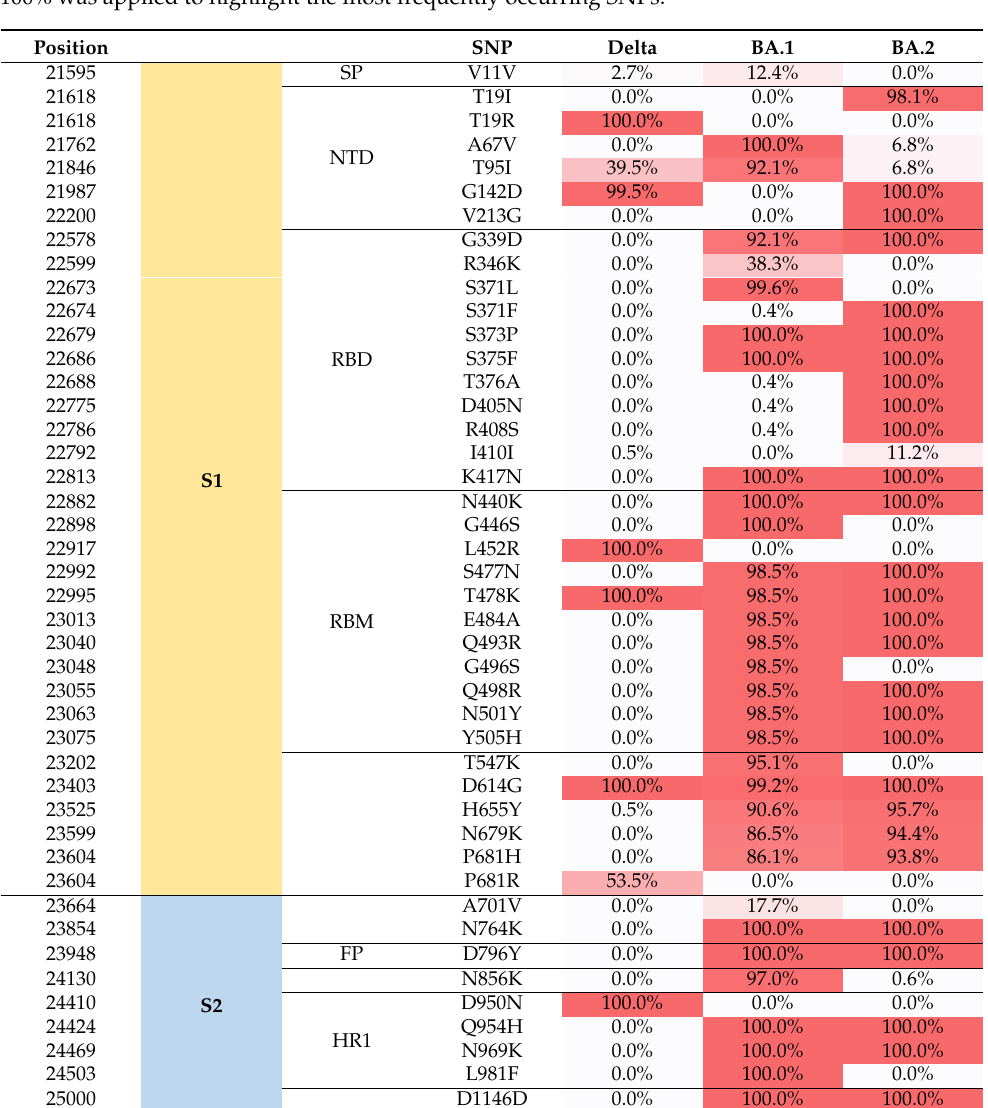
Table 2. Comparison of the frequency of spike protein mutations identified in the three VOCs in Cyprus. Only mutations with a frequency >10% in either variant are shown (NTD: non-structural domain, RBD: receptor-binding domain, RBM: receptor-binding motif, FP: fusion peptide, HR1: heptad repeat 1 region. A color gradient corresponding to the frequencies of SNPs between 0% and 100% was applied to highlight the most frequently occurring